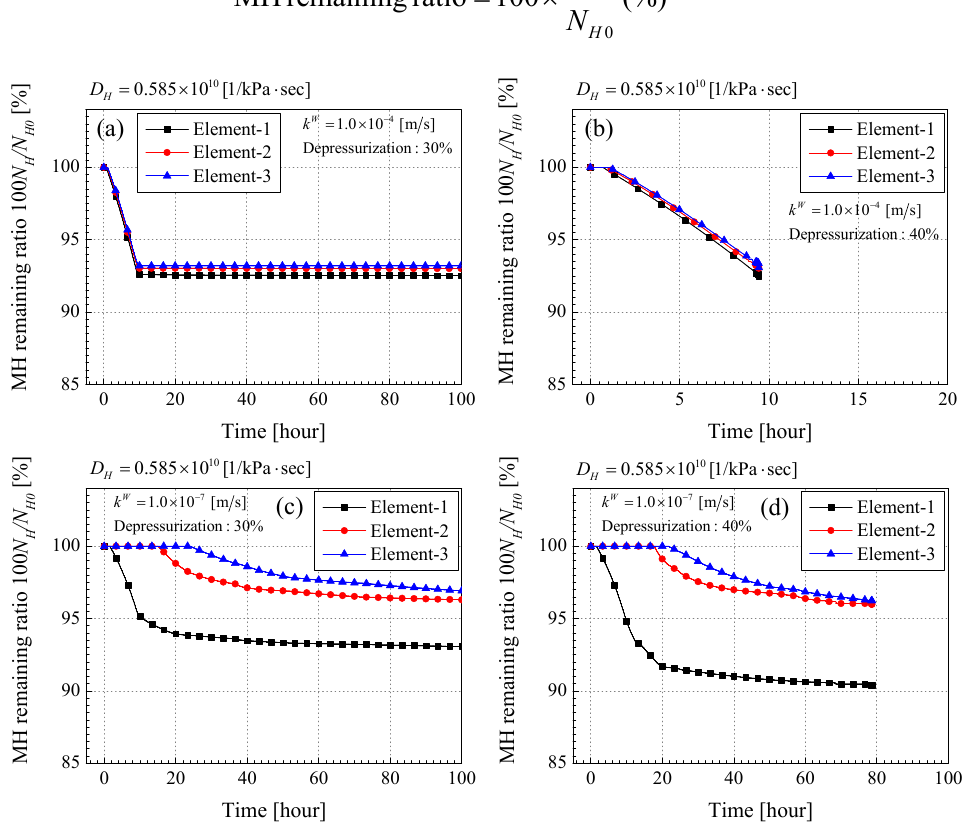
N (%). ( a ) Case-4-30; 100 0 H